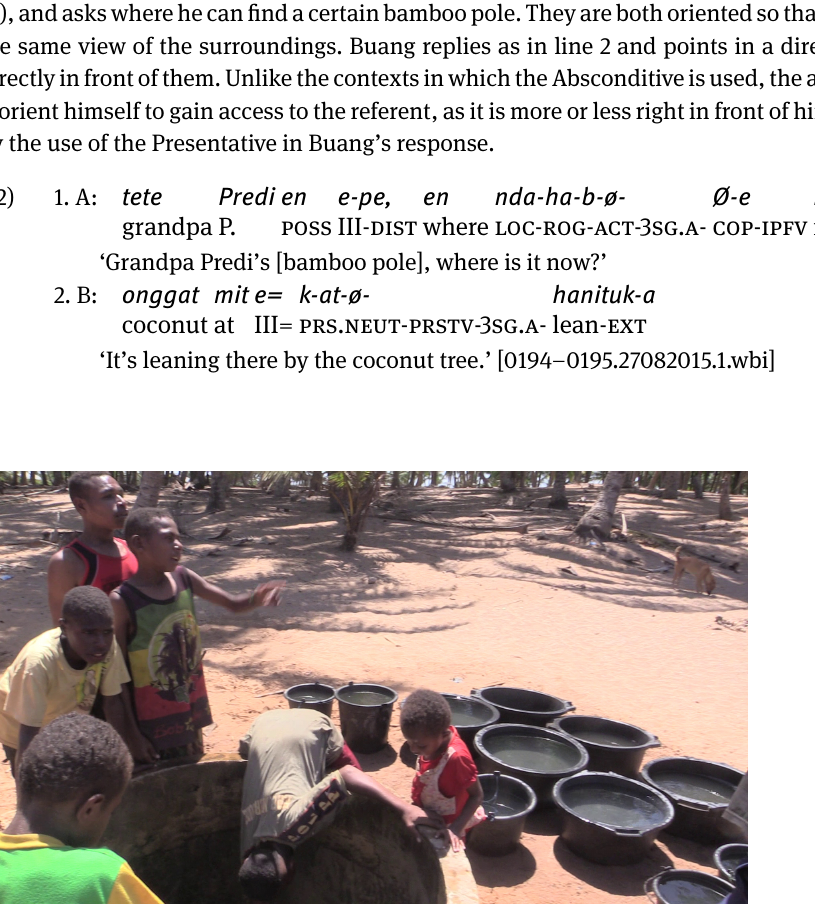
Figure 6: ‘Grandpa Predi’s [bamboo pole], where is it now?—It’s leaning there by the coconut tree.’; cf. example